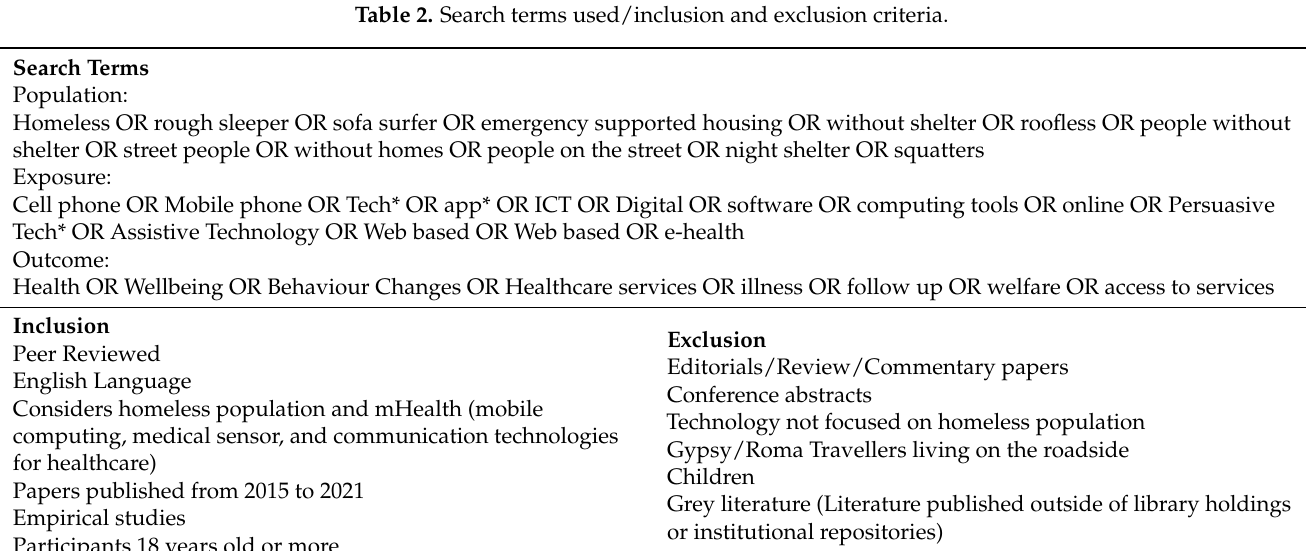
Table 2. Search terms used/inclusion and exclusion